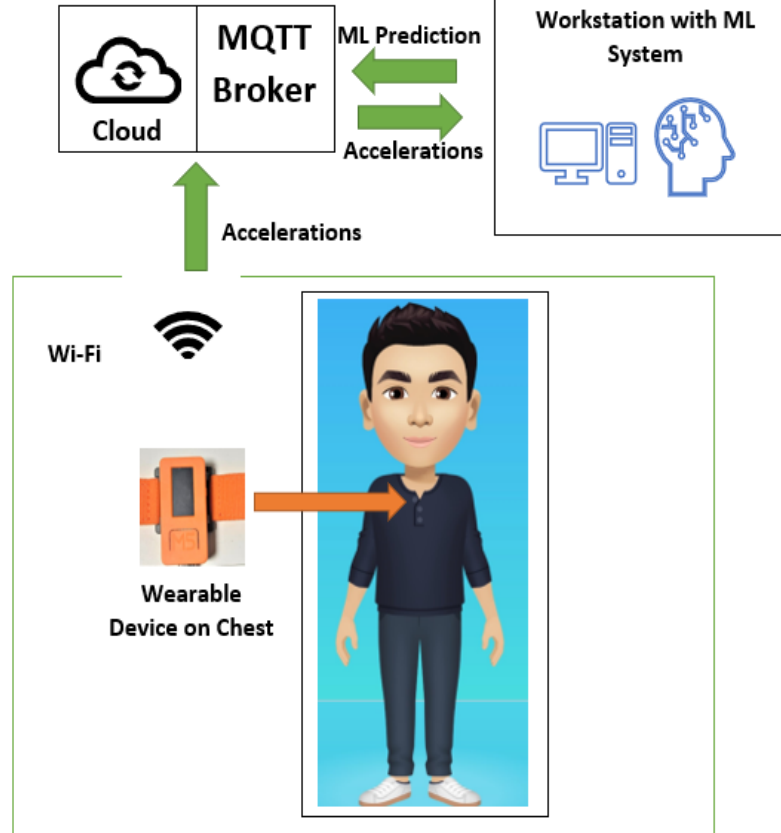
Figure 1. Operation diagram.